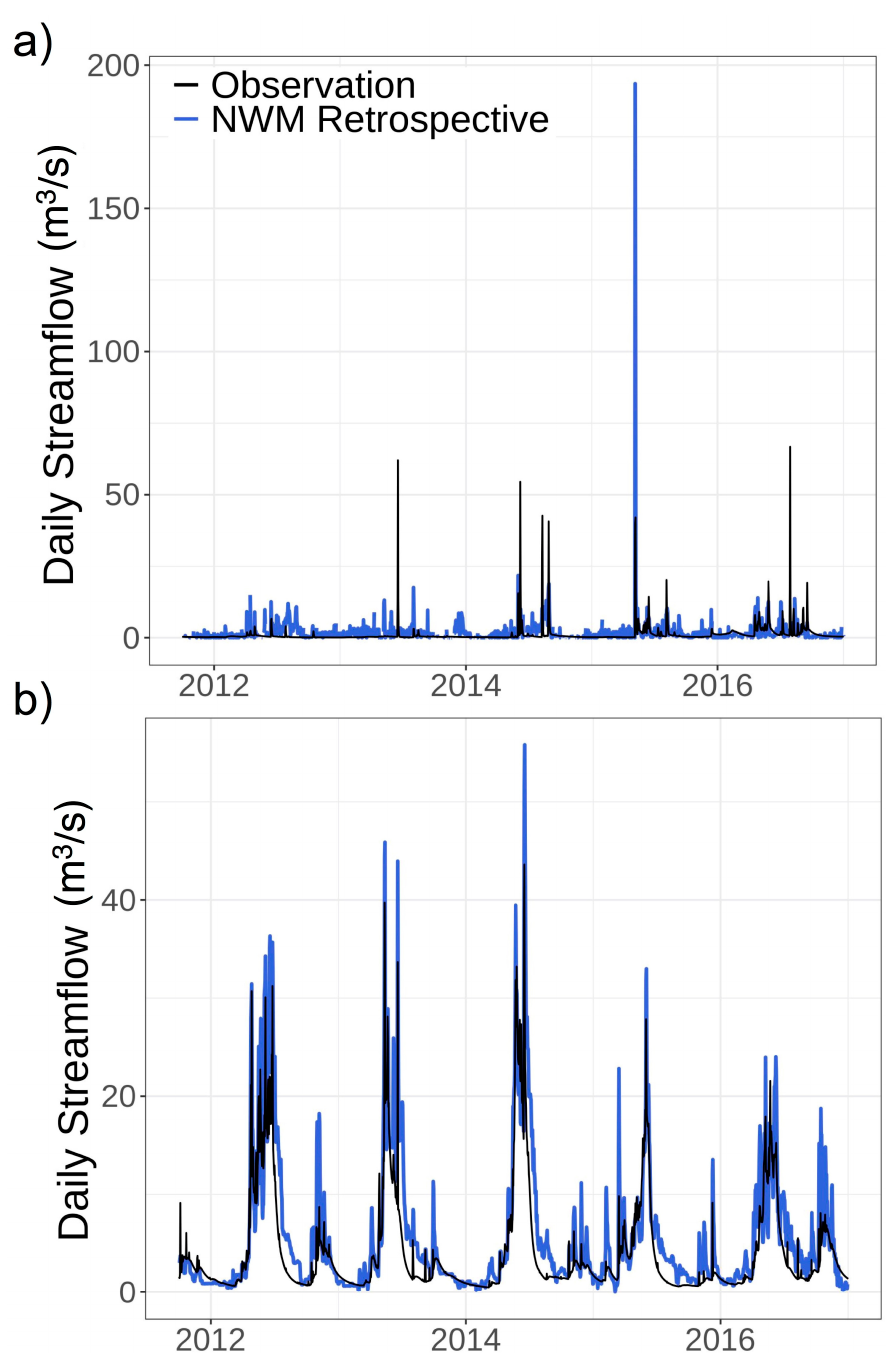
Figure 6. Retrospective comparison of inflows from two sites, Lake Sherburne ( a ) ( sher , 67.7% snow-driven, Canadian Rockies, 23% calibrated) and Lovewell Dam ( b ) ( lvks , 9.2% snow-driven, Central Great Plains, 65% calibrated). Observed is in black, model simulation in gray.